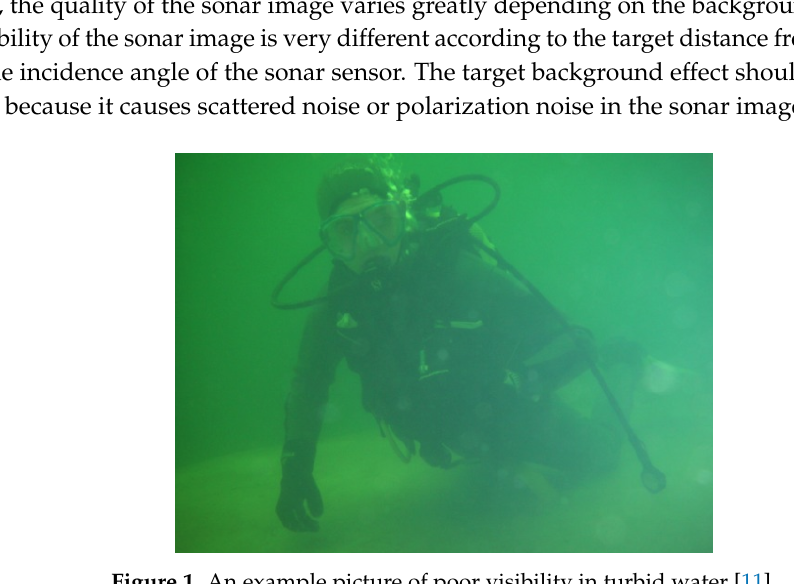
Figure 1. An example picture of poor visibility in turbid water